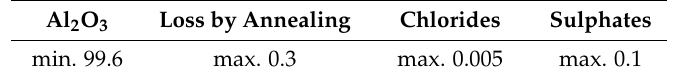
Table 3. Composition of Al 2 O 3 /weight percentage of the additive elements